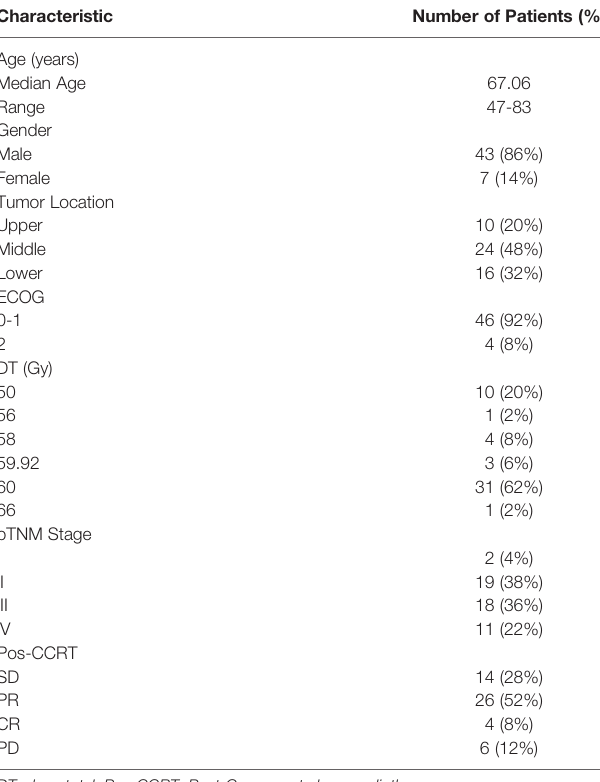
TABLE 1 | Clinical pathology data of patients with esophageal